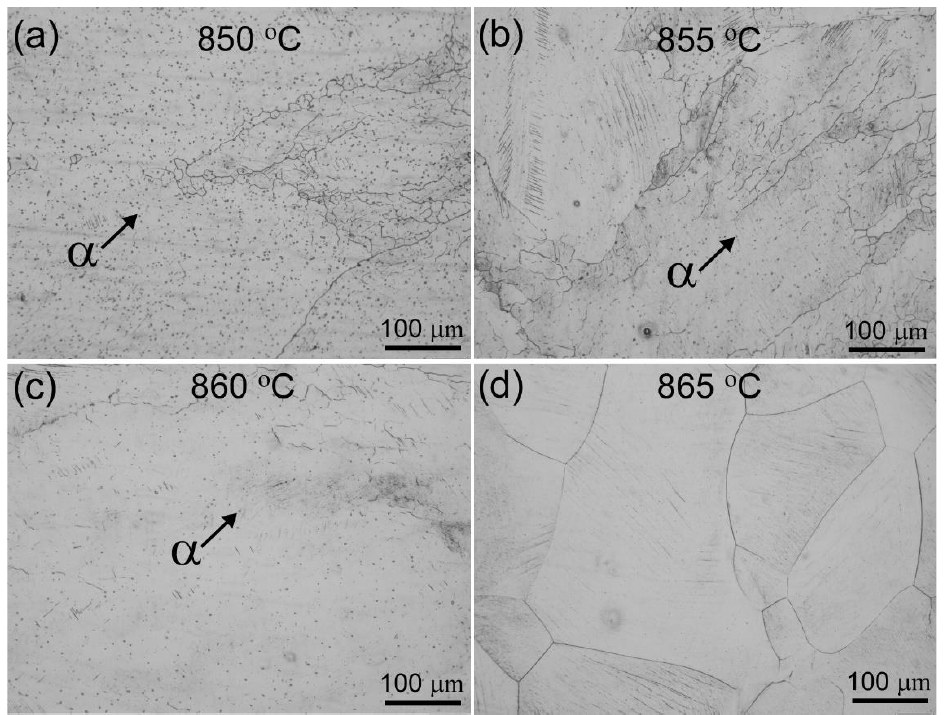
Figure 1. Optical micrographs of the water-quenched Ti55511 alloy at different temperatures: ( a )